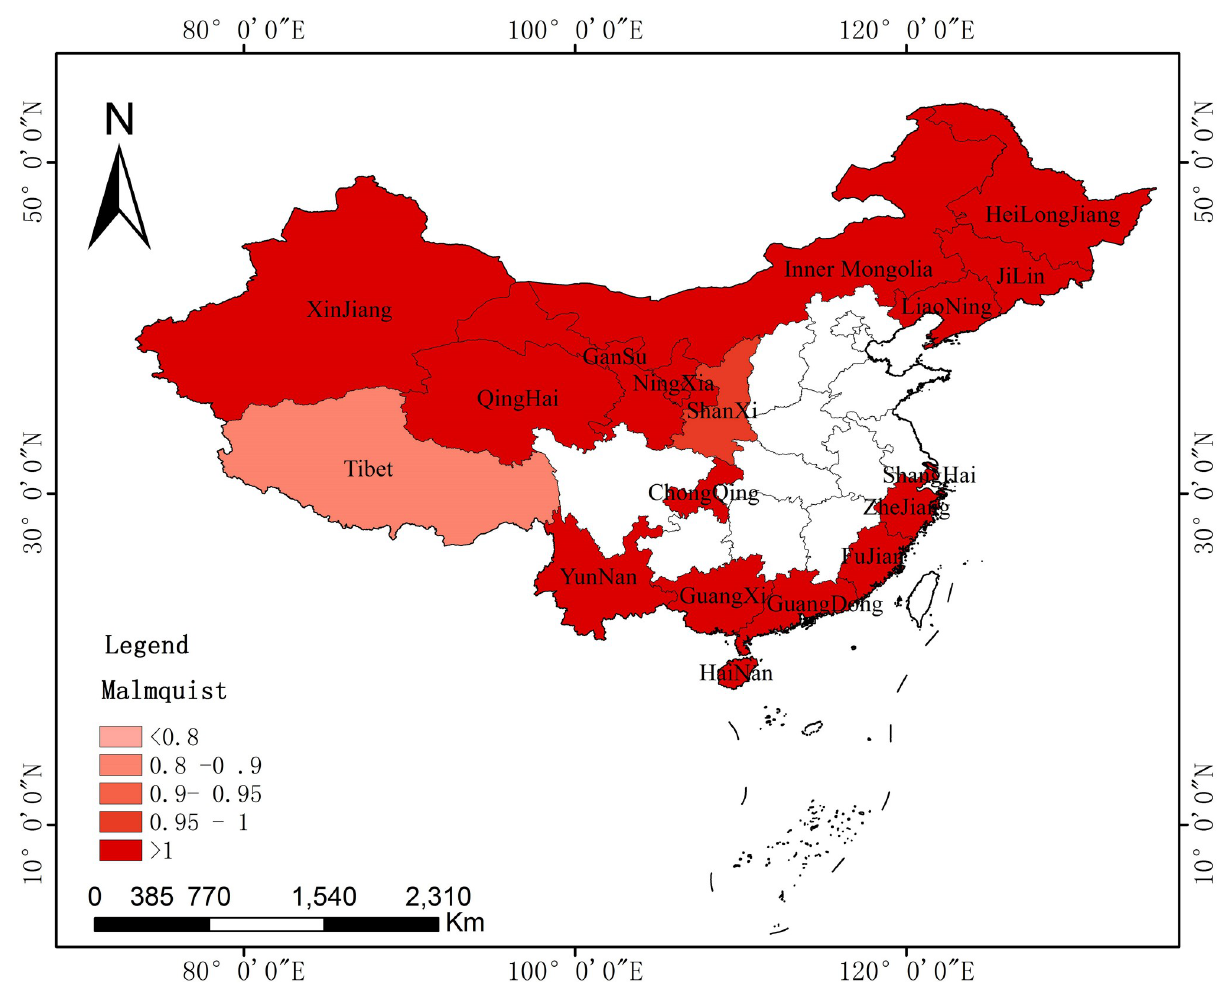
Fig 5. Spatial distributions of the Malmquist index of key provinces along the B&R in 2011.